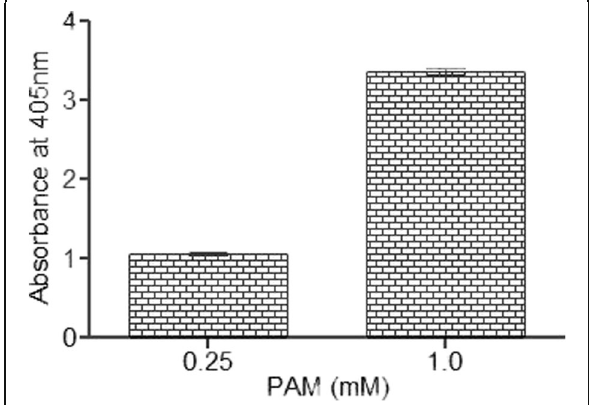
Fig. 7 Esterase-like activity of pralidoxime (PAM) towards acetylthiocholine. Absorbance measured at 405 nm ( n =